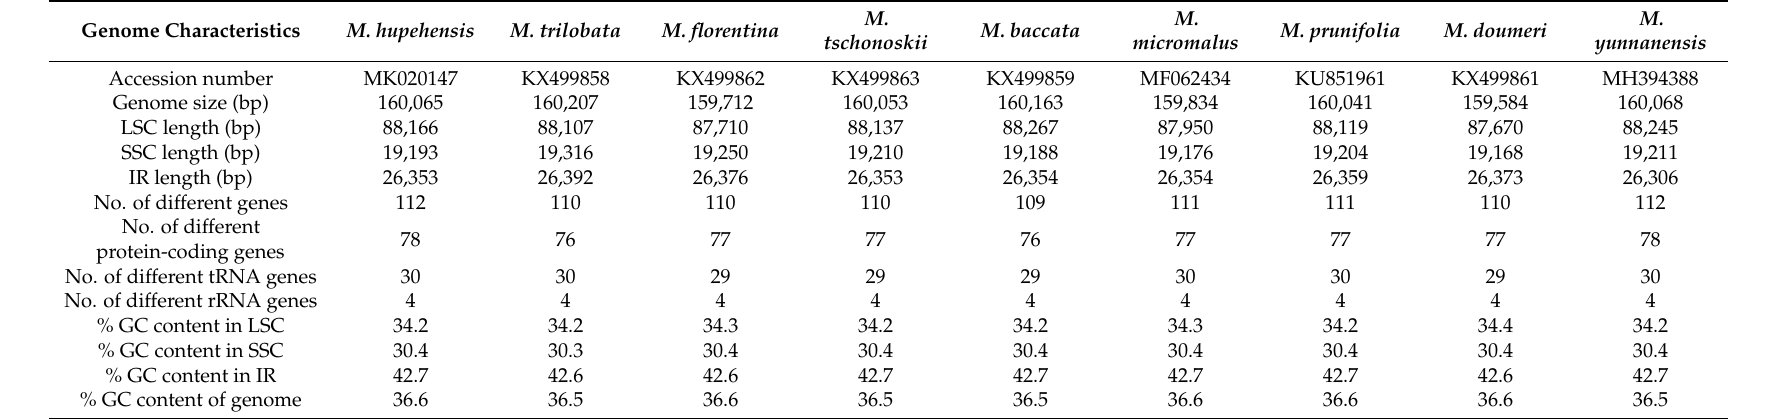
Table 1. Summary of complete chloroplast genomes for nine Malus species.